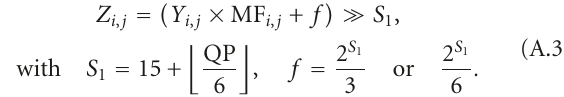
Figure 15: Rate-distortion performance of the luminance com- ponent by four foregrounds embedding and multi-generation